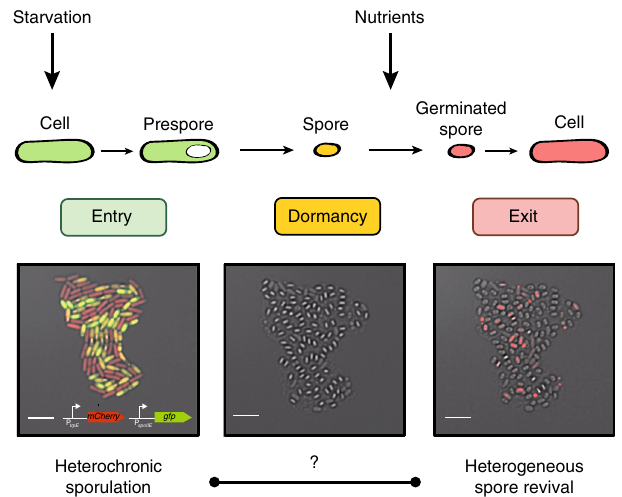
Fig. 1 Tracking the life histories of individual bacteria to study the role of memory in the B. subtilis life cycle. Left: image of a heterogeneously sporulating microcolony. Sporulating cells express GFP from the P spoIIE promoter that is activated at the onset of sporulation. Other cells delay sporulation. They express mCherry from the P trpE* promoter that is active during vegetative growth. Center: image of the same microcolony after sporulation is complete. Right: in response to nutrients, most spores germinate and some grow out. Scale bars: 5 µ m. Strain: